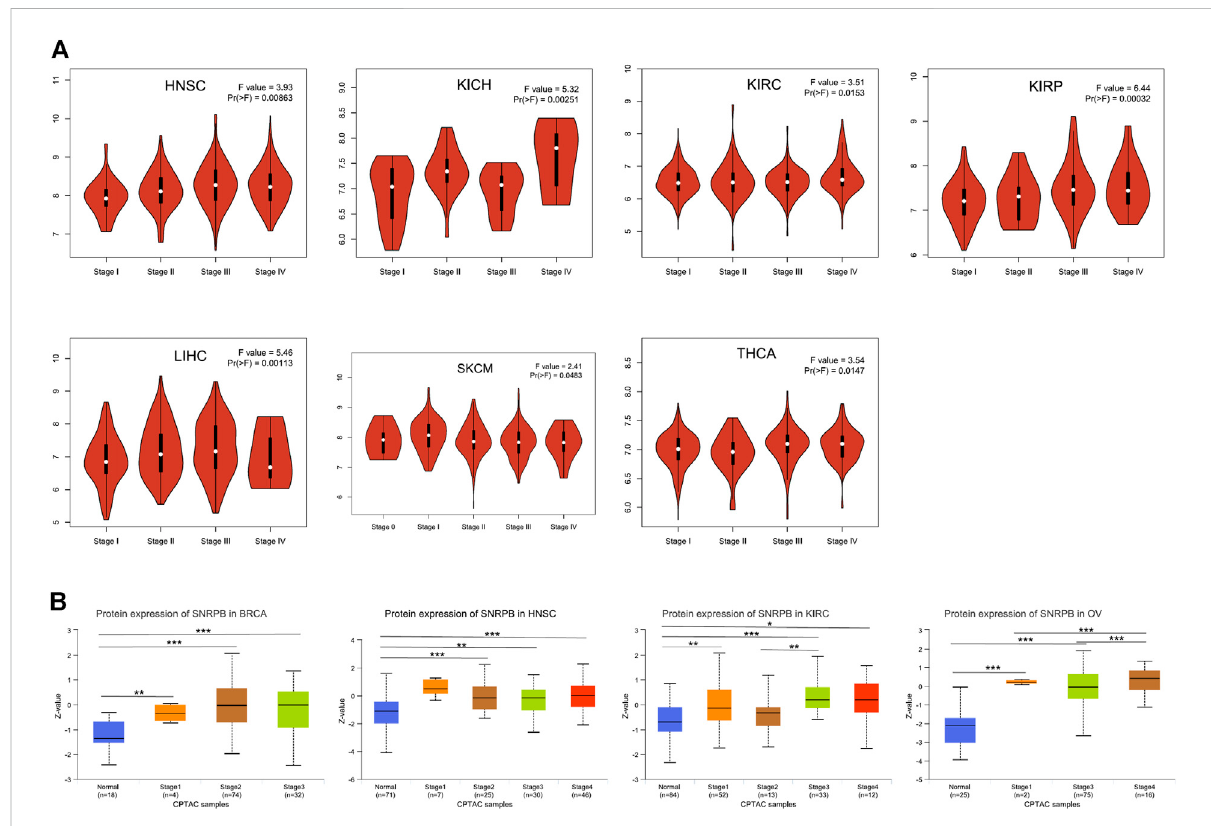
FIGURE 3 mRNA and protein expression levels of SNRPB in different pathological stages across tumors. (A) mRNA expression level of SNRPB in different pathological stages. (B) . Protein expression level of SNRPB in different pathological stages.*, p < 0.05; **, p < 0.01; ***, p <